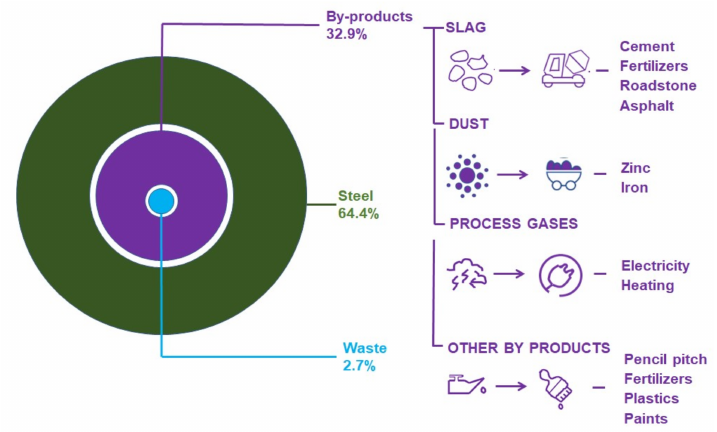
Figure 2. Reuse of steelmaking